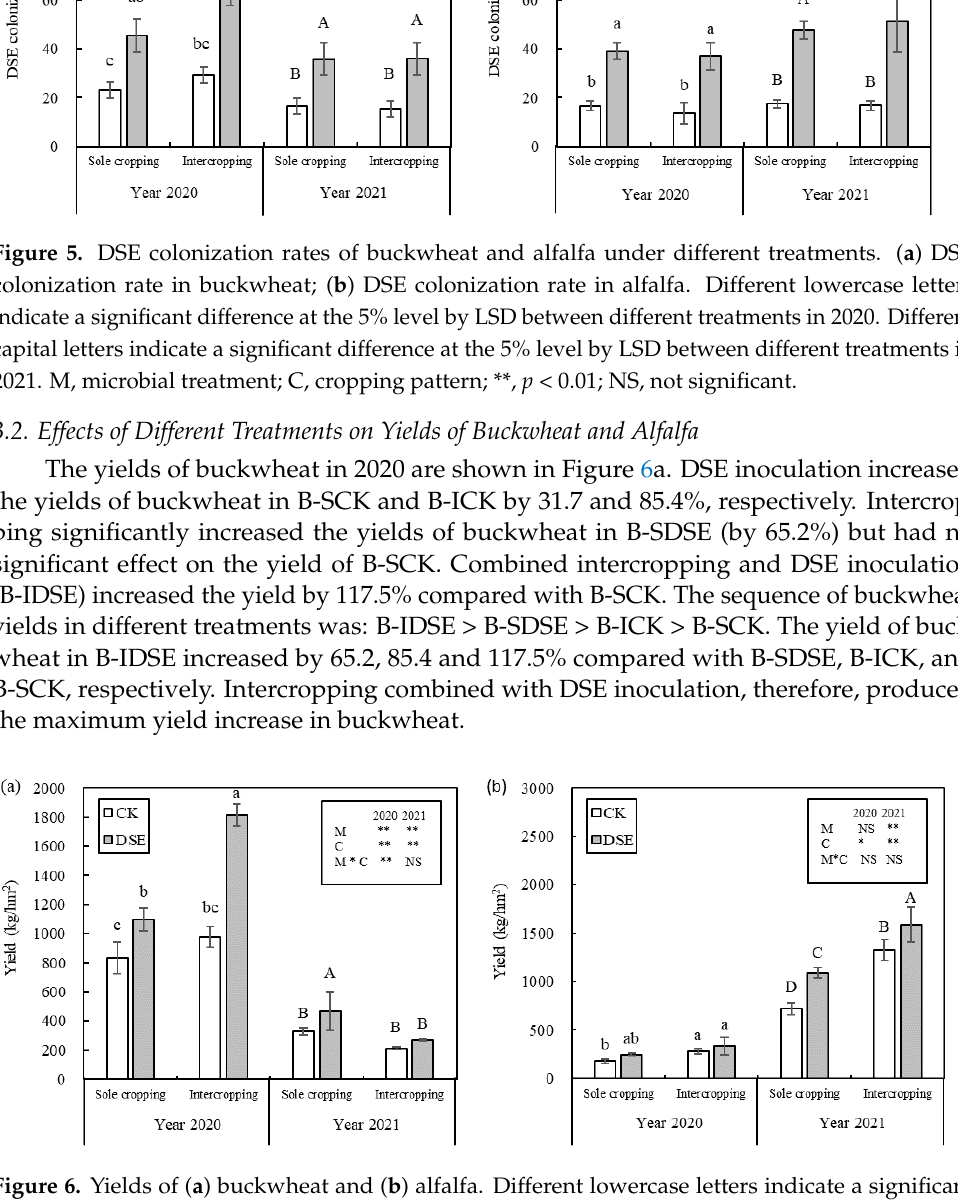
Figure 6. Yields of ( a ) buckwheat and ( b ) alfalfa. Different lowercase letters indicate a significant difference at the 5% level by LSD between different treatments in 2020. Different capital letters indicate a significant difference at the 5% level by LSD between different treatments in 2021. M, microbial treatment; C, cropping pattern; *, p < 0.05; **, p < 0.01; NS, not significant.